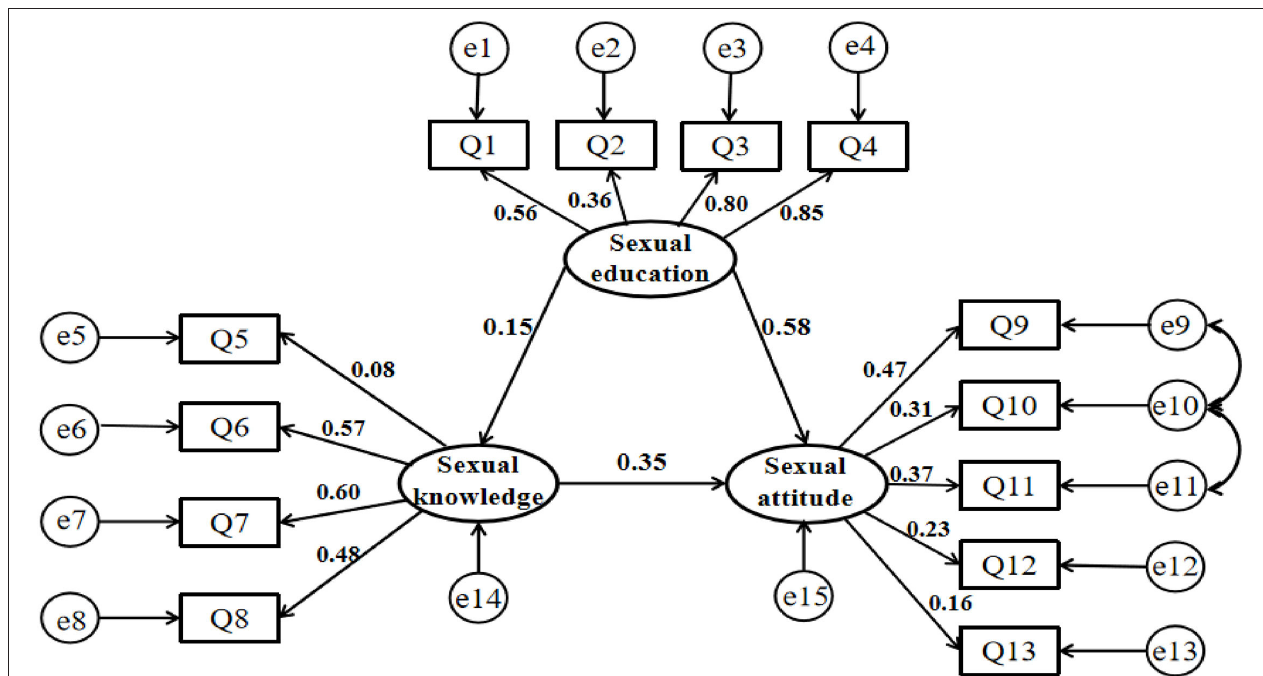
FIGURE 2 | Diagram of structural equation